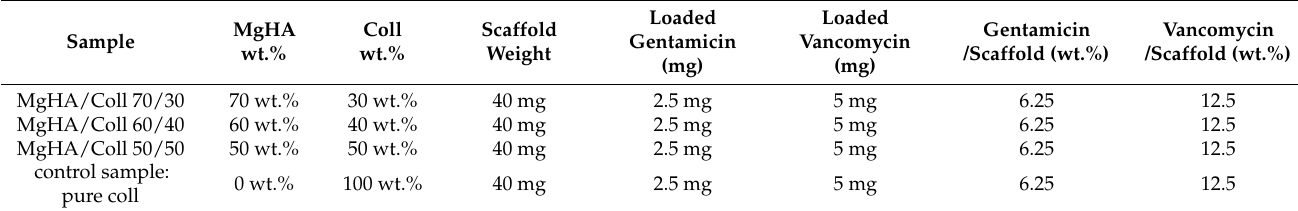
Figure 1. Scheme of the protocol for drug loading and release from the hybrid scaffold. The quantification of the released drug was evaluated at specific time points by UV-Vis analyses. Table 1. Description of the samples’ composition and prepared drug-loaded